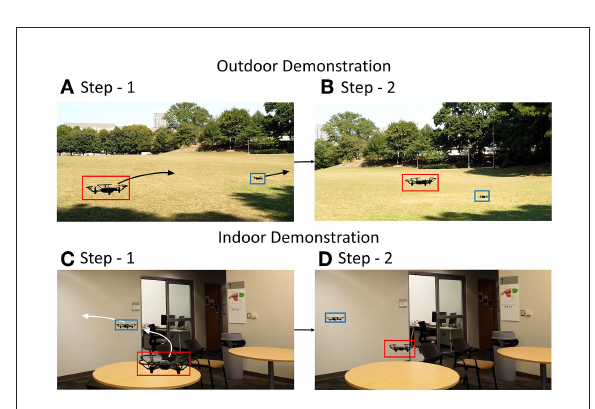
FIGURE8 Screenshots from real-world experiments in (A,B) outdoor and (C,D) indoor scenario. The trajectories of the prey and predator are shown by the arrows with final positions in